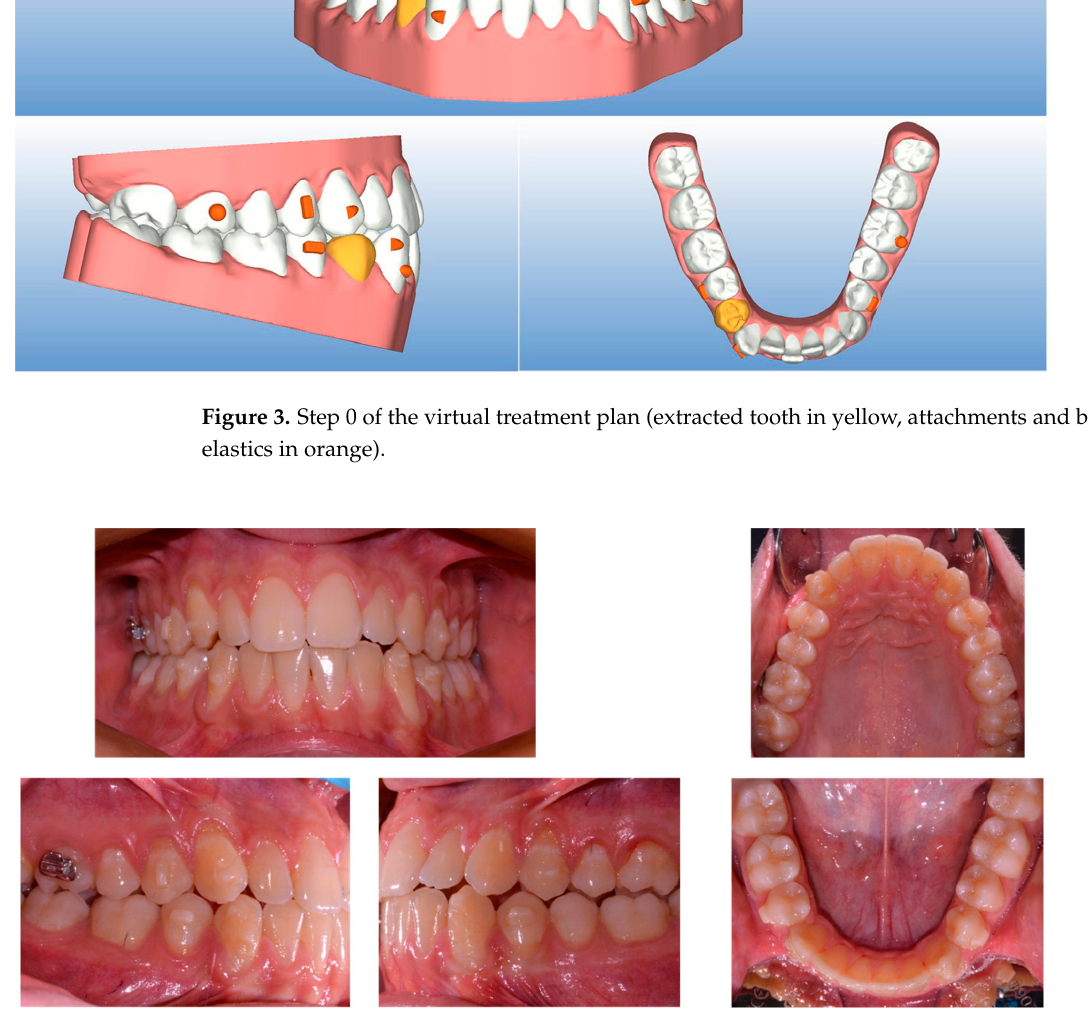
Figure 3. Step 0 of the virtual treatment plan (extracted tooth in yellow, attachments and buttons for elastics in orange).